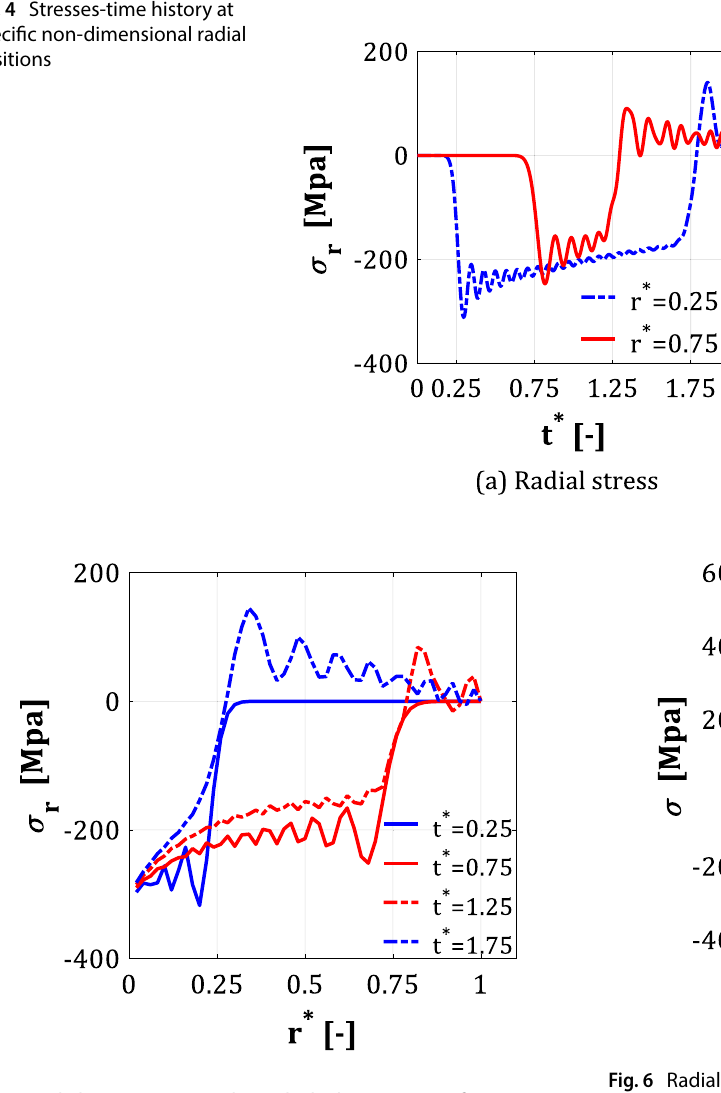
Fig. 5 Radial stress variation through-thickness at specific t*